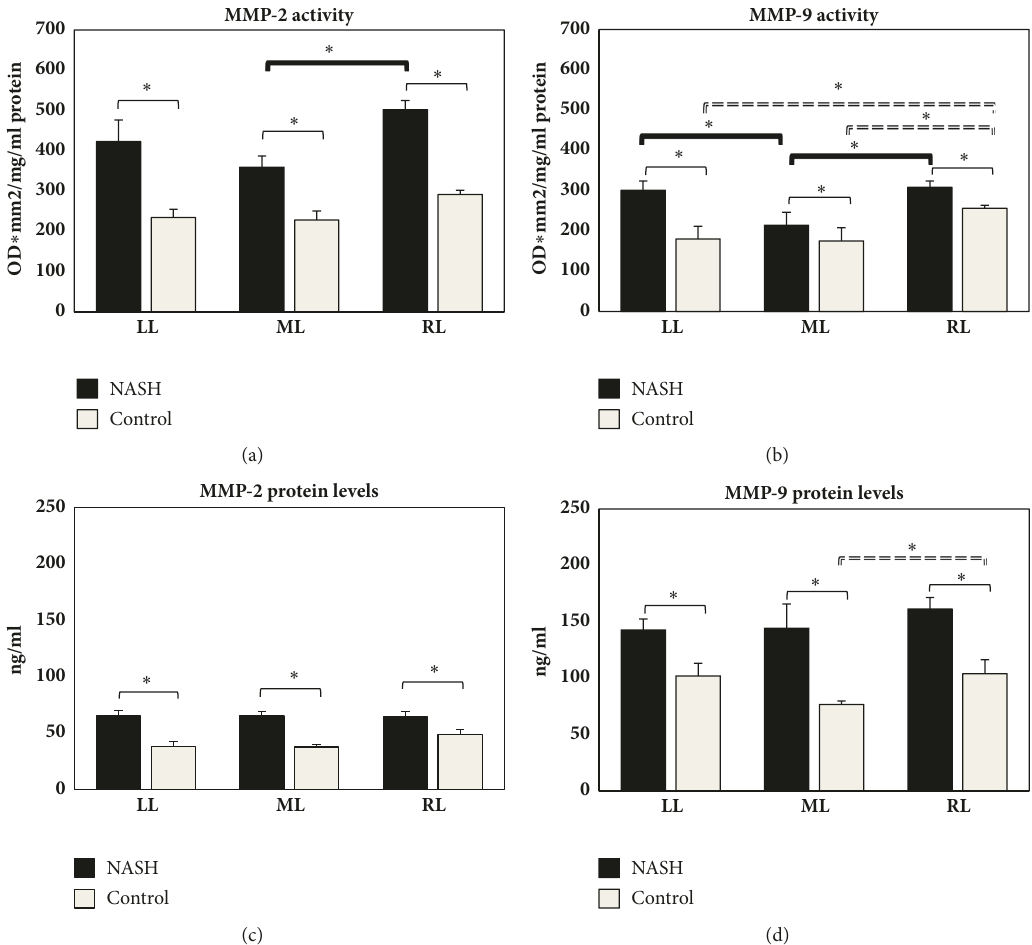
Figure 2: Hepatic content in MMP-2 and MMP-9 activity ((a) and (b)) and MMP-2 and MMP-9 protein levels ((c) and (d)) obtained from LL, ML, and RL in NASH and control rats. MMP gelatinase activity is expressed as optical density (OD) for mm 2 , related to 1 mg/mL protein content. MMP protein content is expressed in ng/mL. Data are shown as mean values ± SE. ∗ p < 0.05.